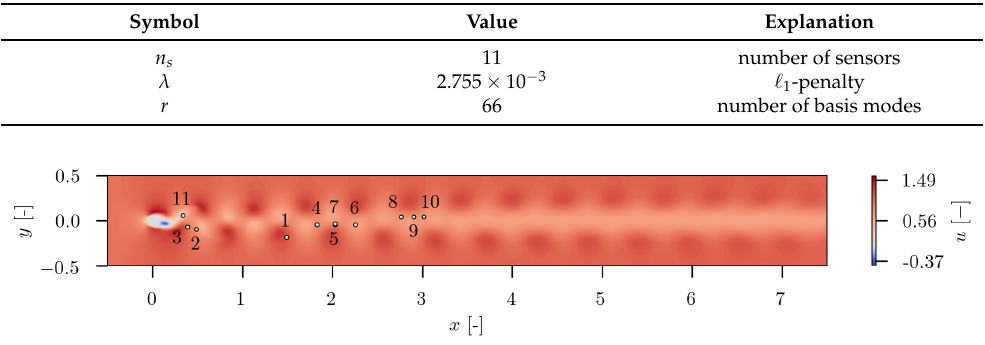
Table 7. Optimum values for sensor placement by means of SSPOC.